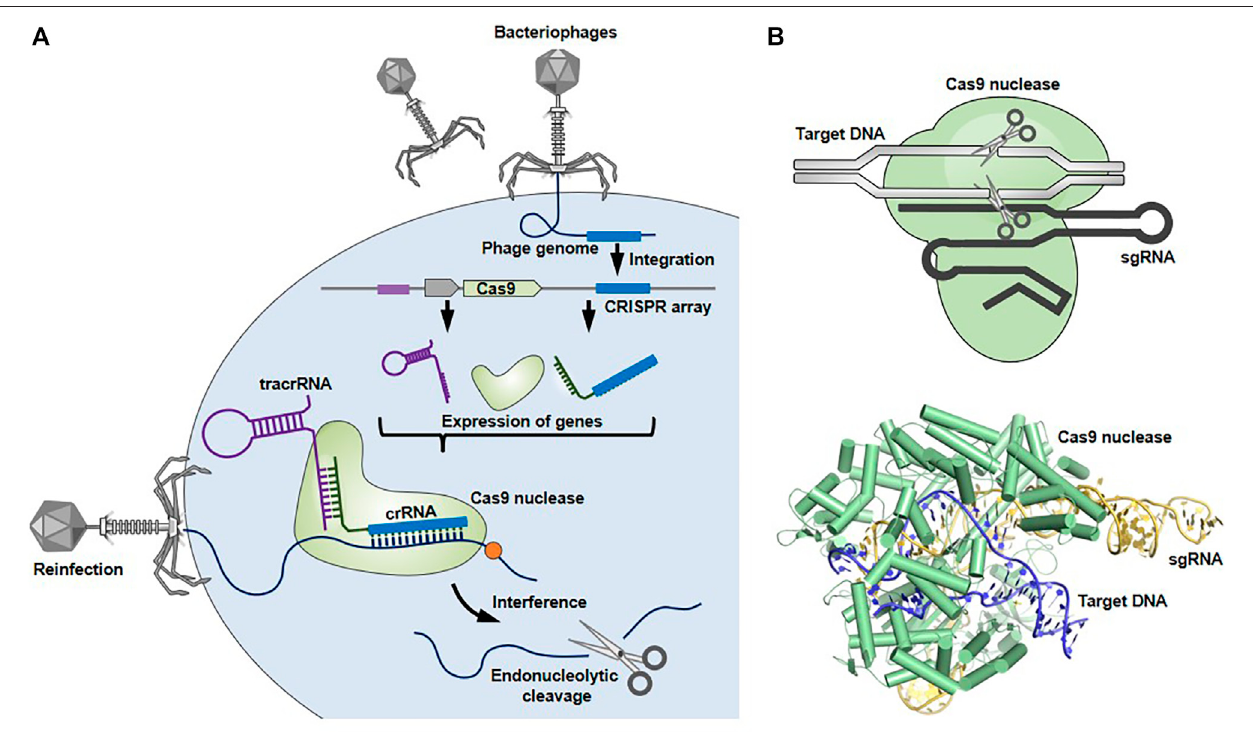
FIGURE 1 | Bacterial CRISPR-Cas9 system. (A) CRISPR-Cas9 system works as a host defense system. When an invader (e.g., bacteriophage) infects bacterial cells, spacer-sized DNAs derived from the invader ’ s genome are incorporated into the CRISPR locus of the bacterial genome. Upon subsequent infection, the gRNA- Cas9 complex recognizes and cleaves the target genome sequences of re-invading pathogens to protect the bacteria from lethal infection. (B) The structures of gRNA- Cas9 complex (Protein Data Bank in Europe, 5F9R) were drawn using the open-source PyMOL Molecular Graphics System version 1.8.6.0.